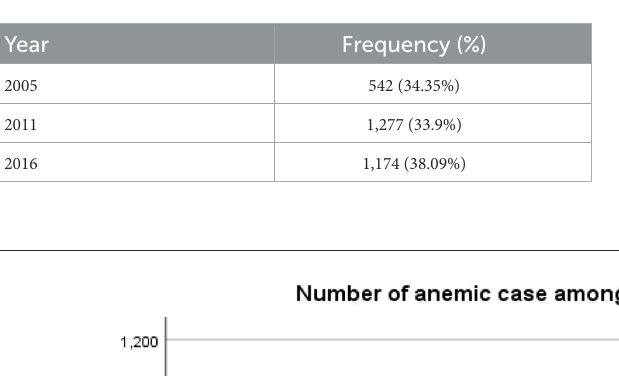
TABLE 1 The prevalence of anemia among pregnant women in 2005, 2011, and 2016 EDHS data.